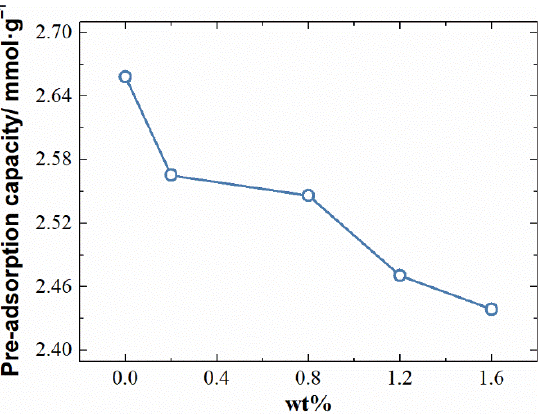
Figure 18. Free volume and surface area of the shale model with different water contents.